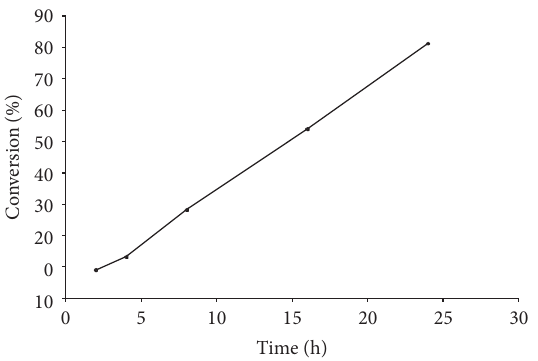
Figure 4: Effect of reaction time for the conversion of 2-hexenal using Au/MnO 2 . Reaction conditions: 4.23 g of 2-hexenal, 0.06 g of catalyst, atmospheric pressure.